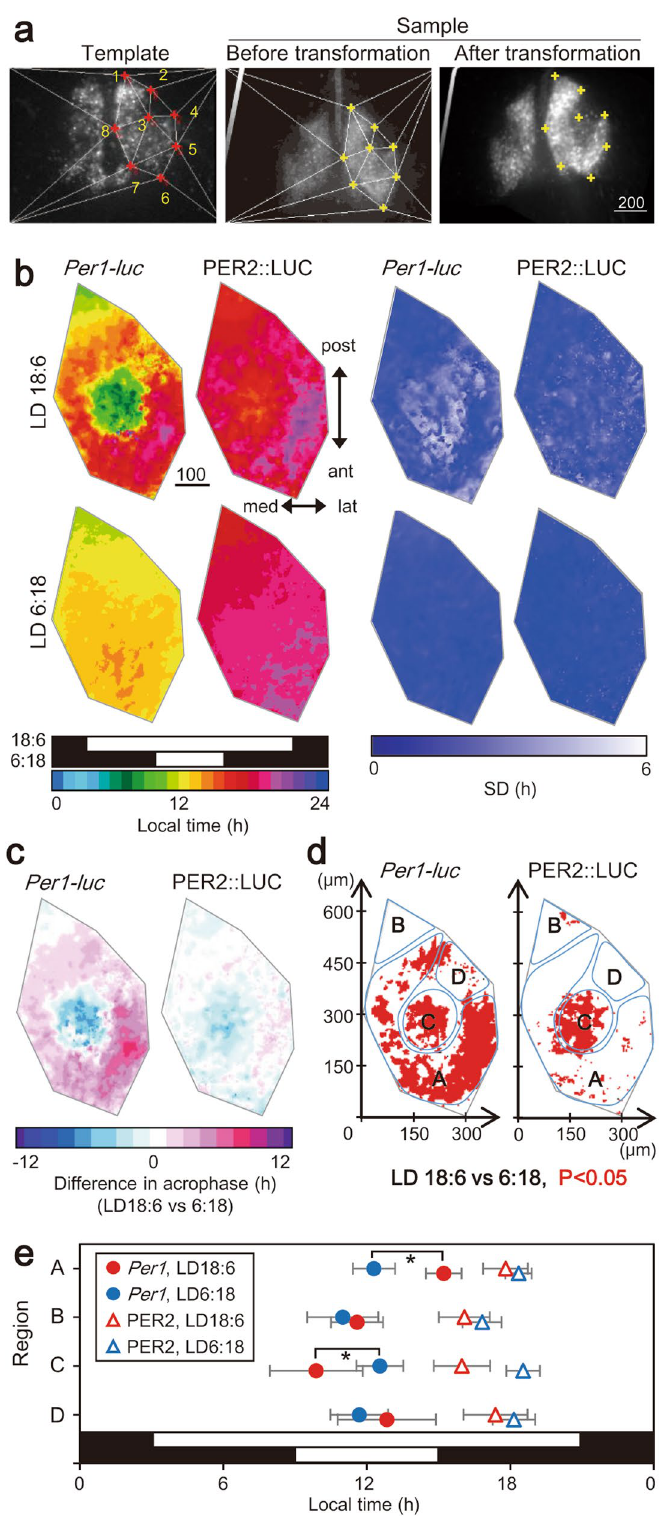
Figure 4. Statistical evaluation of acrophase of Per1-luc and PER2::LUC rhythms on pixel level. ( a ) Geometric transformation of an SCN bioluminescence image for statistical analyses on pixel level; a template SCN (left), a sample SCN before (middle) and after (right) the transformation. Red and yellow crosses with white lines (Delaunay triangles) in the panels indicate eight reference points in the template (1-8) and a sample SCN. ( b ) The mean acrophase map composed of five standardized images of individual SCN slices (Supplementary Fig. 2) are illustrated for Per1-luc (far left) and PER2::LUC (left) rhythms. Respective SD map is demonstrated in the right half. Horizontal black and white bars indicate light and dark phases of the photoperiod (upper, LD18:6; lower, LD6:18) with local time. SD values are indicated by pseudocolor bar. ( c ) Mean phase difference